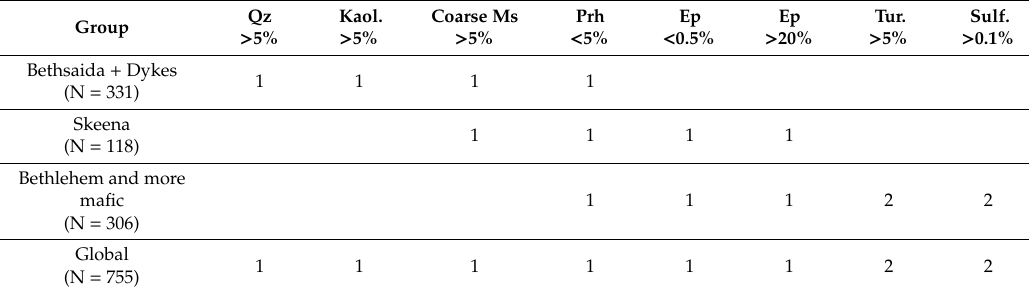
Table 2. Mineralogical parameters used for the spectral alteration score